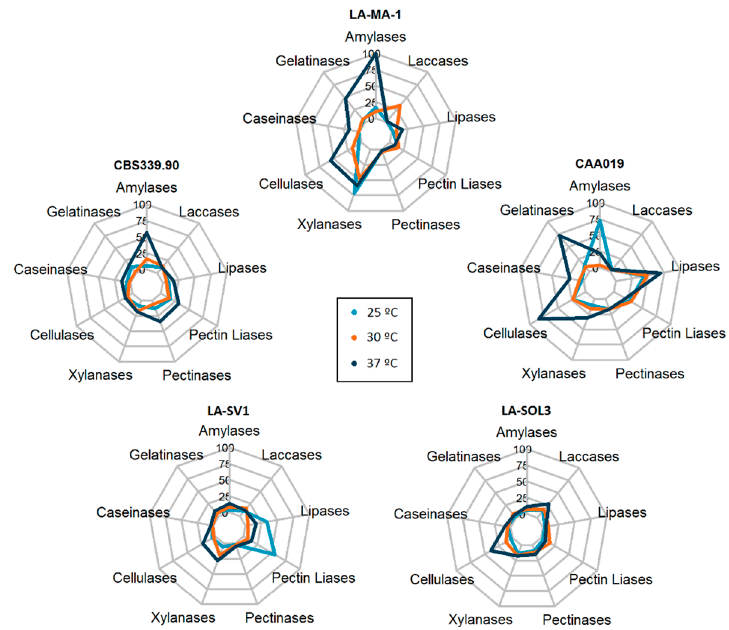
Figure 2. Extracellular enzymatic activity (%) of L. theobromae strains after a 48-h incubation period. The percentages were calculated using the higher enzymatic index determined as 100%.